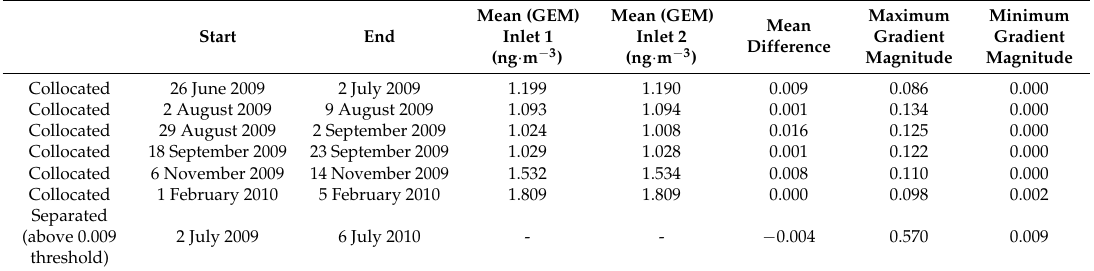
Table 2. Mean GEM concentration when both sampling inlets were located at 1